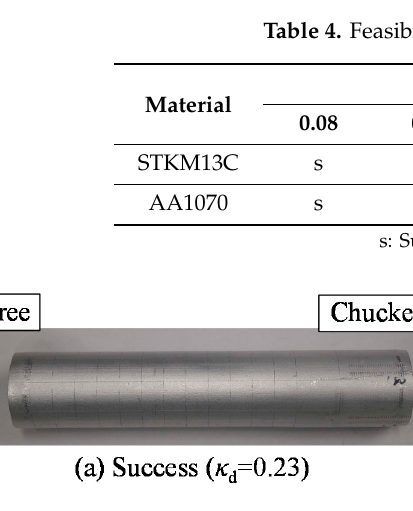
Figure 14. Typical appearances of drawn tubes (AA1070).